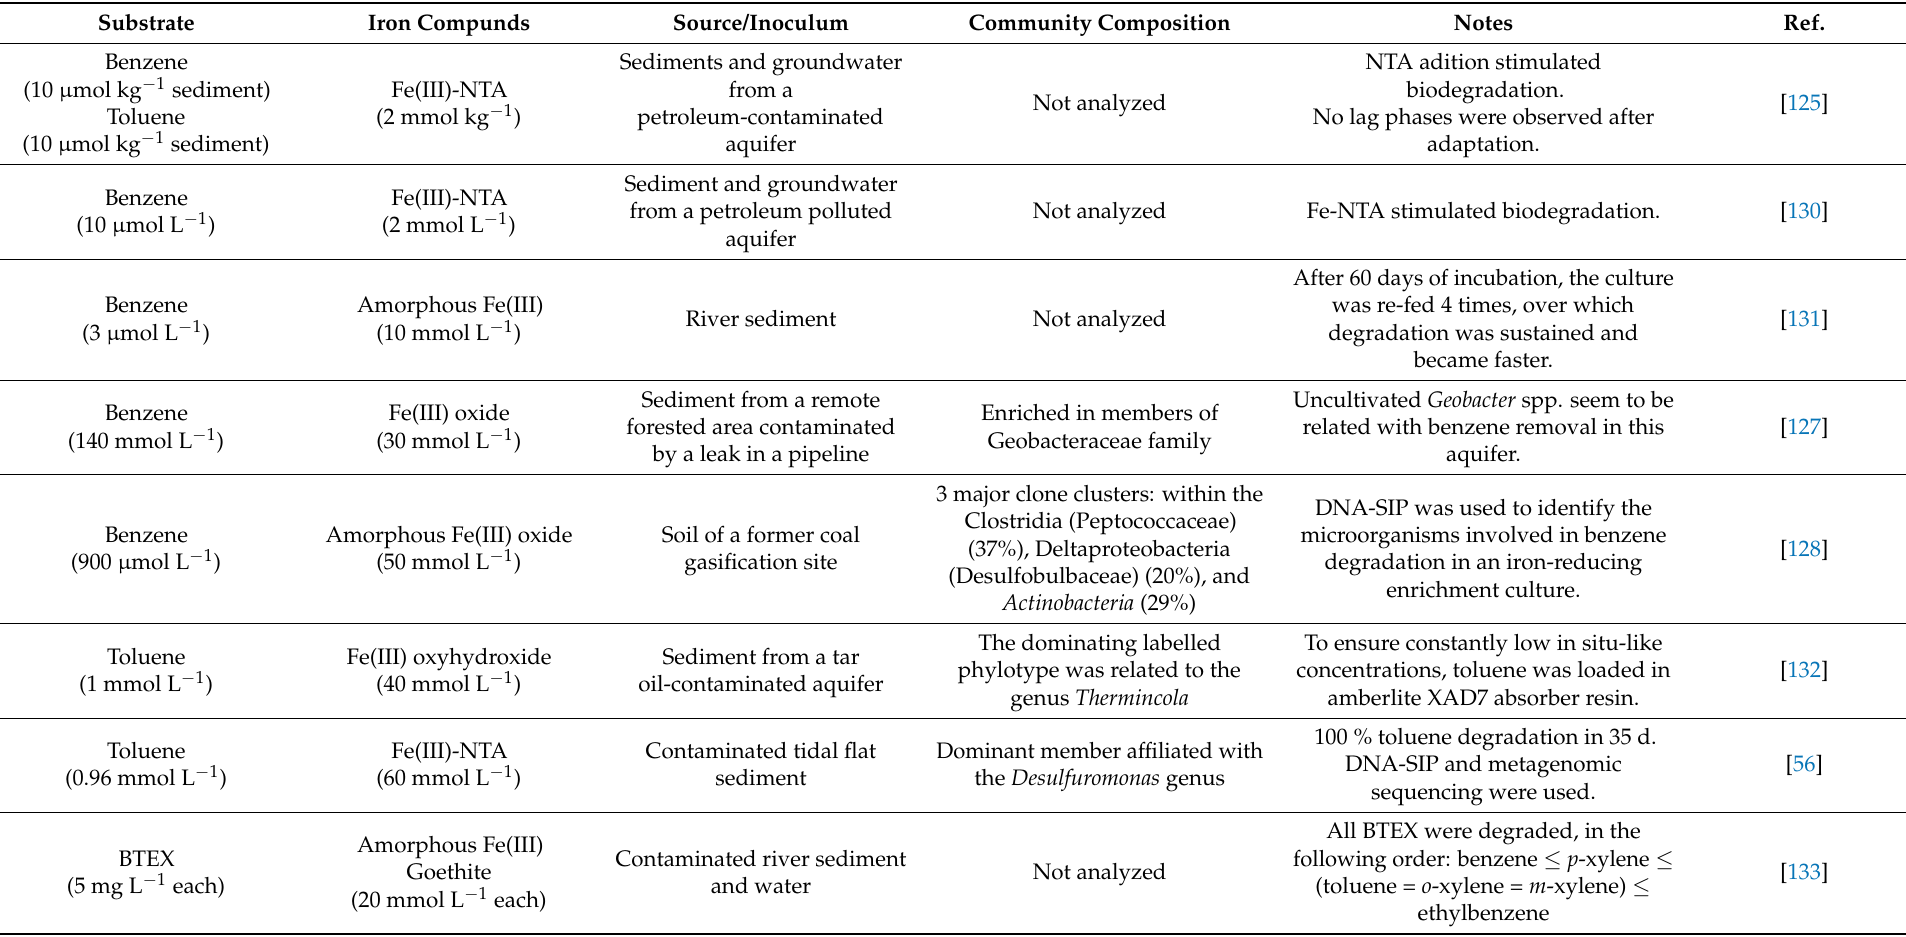
Table 3. Overview of monoaromatic hydrocarbons degradation coupled to Fe(III) reduction in microcosms and enrichment